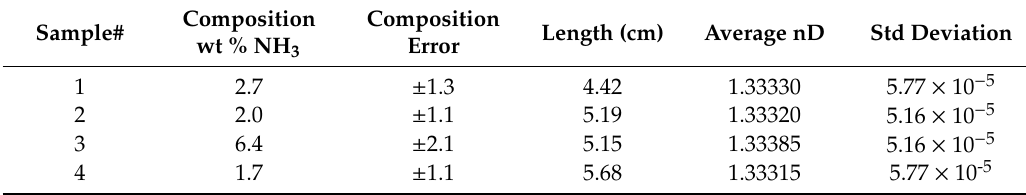
Table 1. Sample characterization for ultrasonic